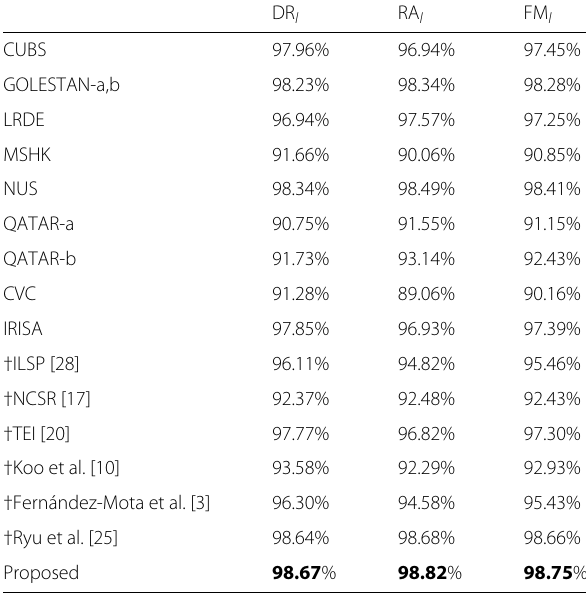
Table 3 Experimental results on the ICDAR 2013 dataset